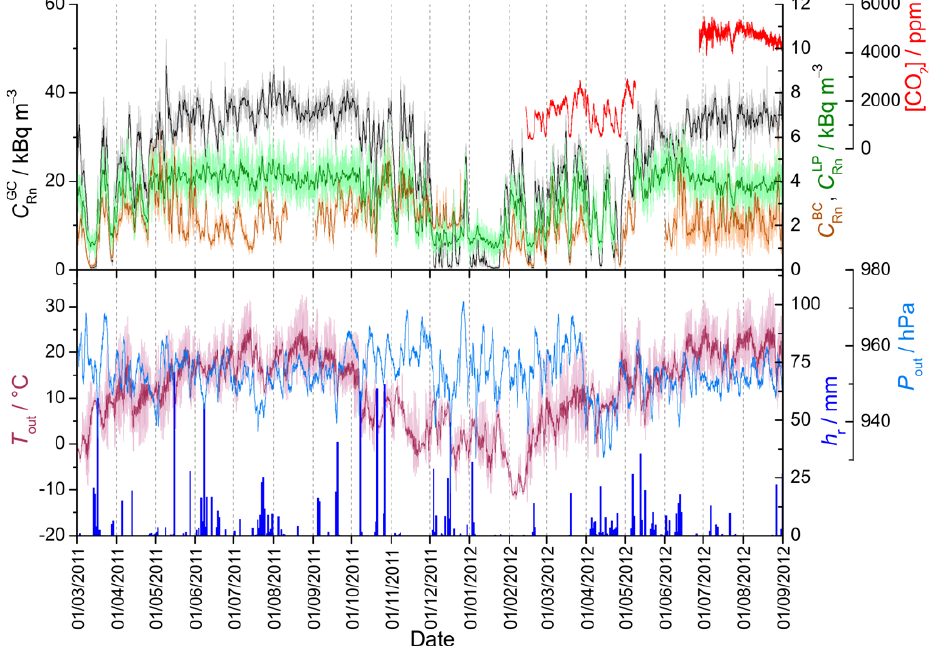
) , Lepe jame – C BC and the lowest point – C LP Rn Rn Rn